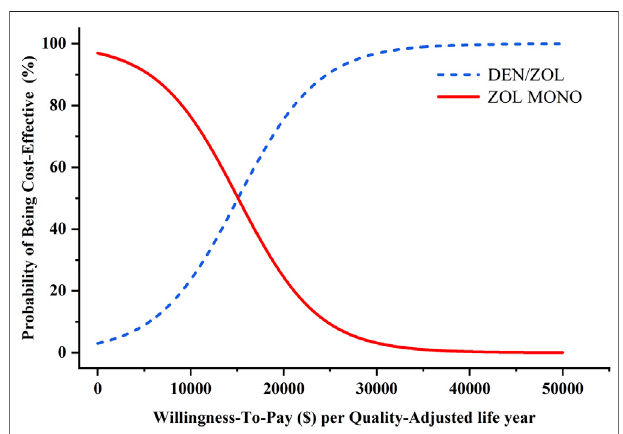
FIGURE 2 | Results of probabilistic sensitivity analyses, age 80 years. The cost-effectiveness acceptability curves represent probabilities of sequential denosumab/zoledronic acid relative to zoledronic acid monotherapy being cost-effective (abbreviations: ZOL, zoledronic acid monotherapy; DEN,